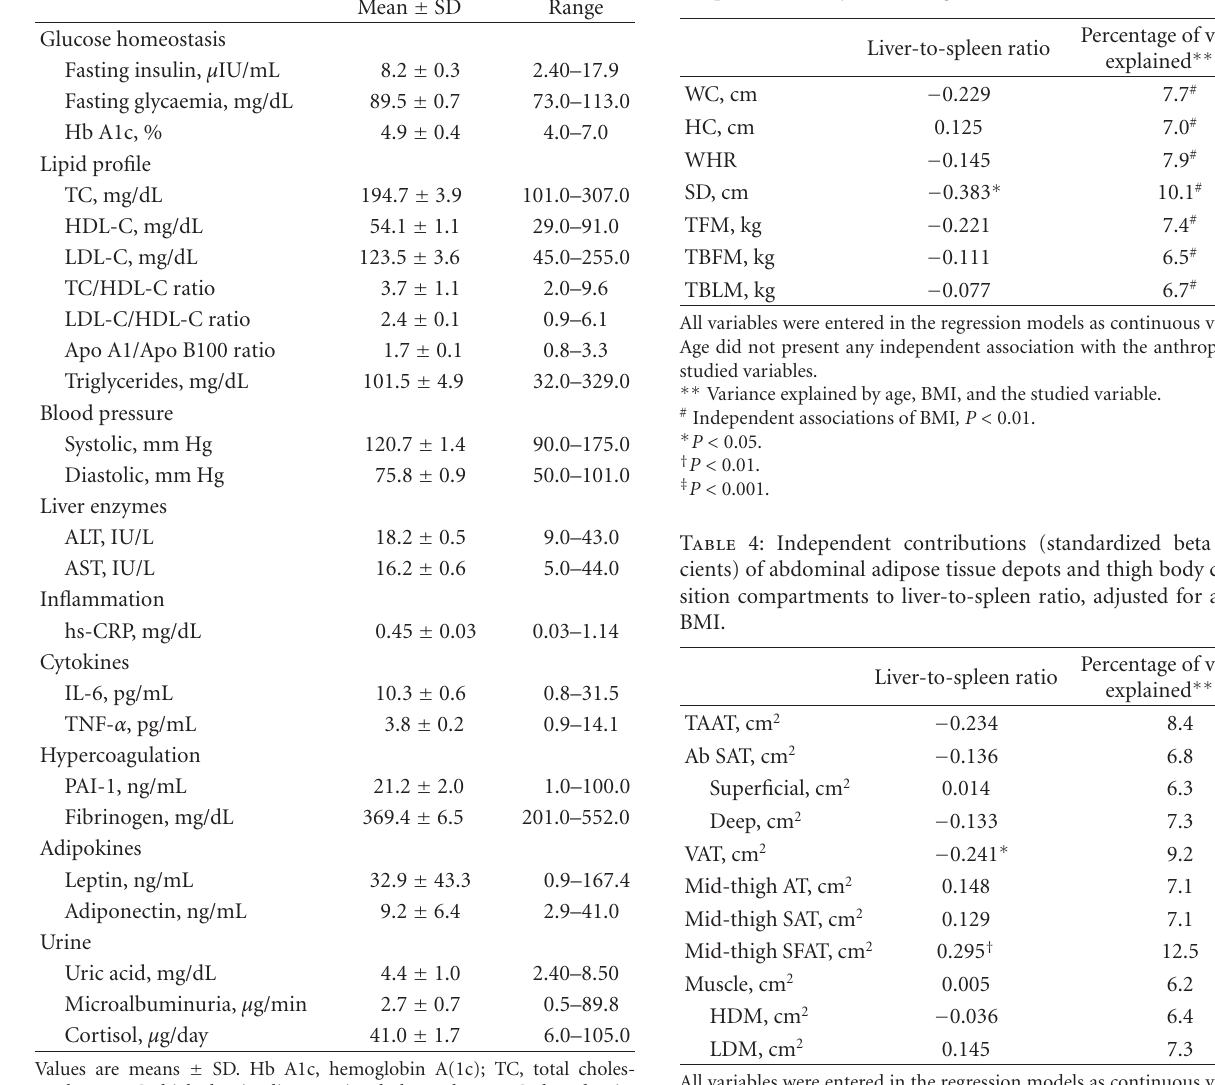
Table 3: Independent contributions (standardized beta coe ffi - cients) of anthropometric and body composition variables to liver- to-spleen ratio, adjusted for age and BMI.